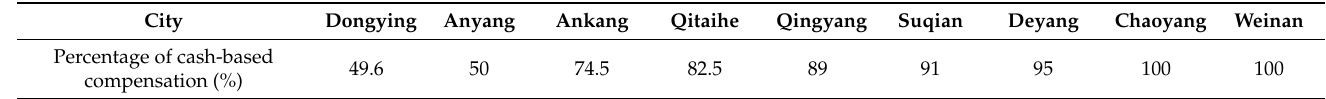
Table 6. The percentage of cash-based compensation for resettlement in several cities in